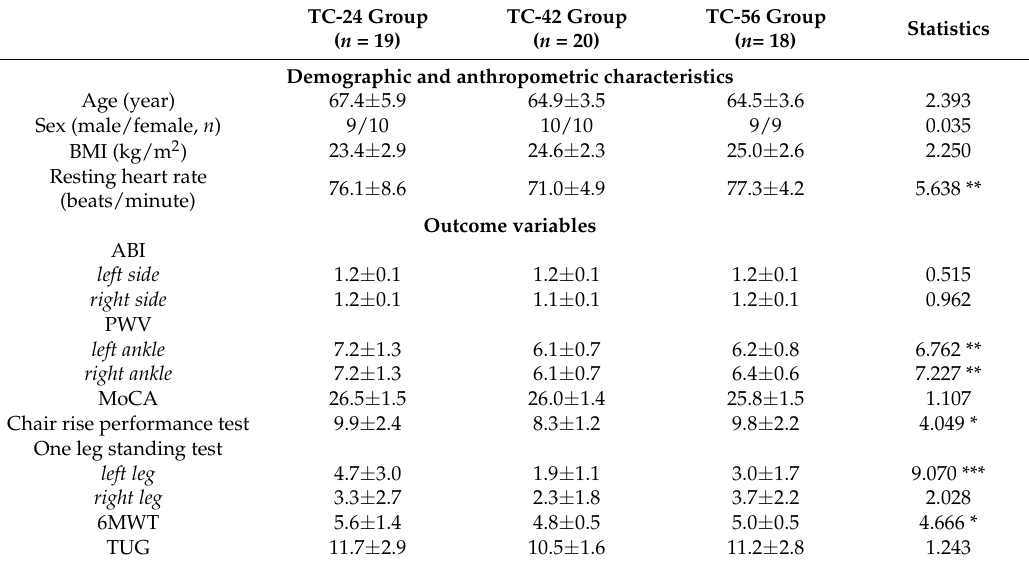
Table 1. All outcome measures across groups at baseline (mean ±